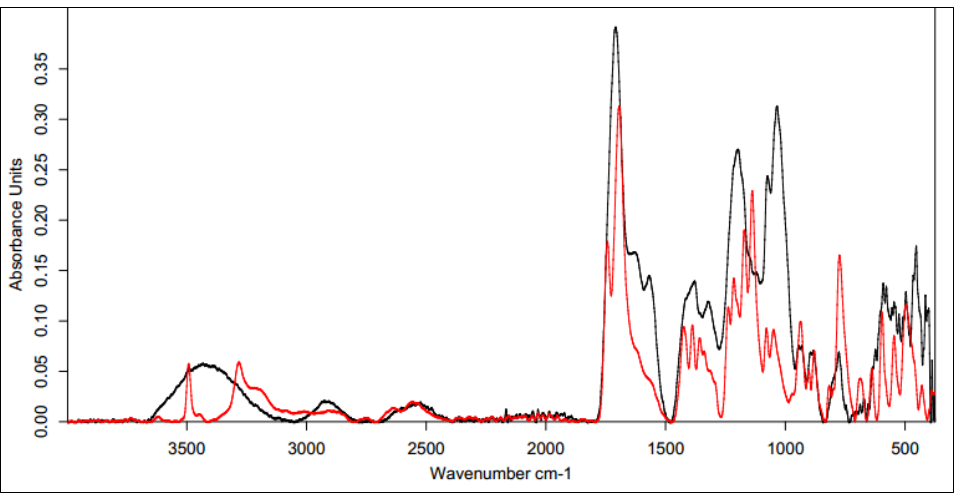
Figure 13. IR spectrum for 2% hyaluronic-acid-coated carbon nonwoven samples cross-linked with citric acid of di ff erent concentrations (black line: CA 5%, red line: CA 20%).